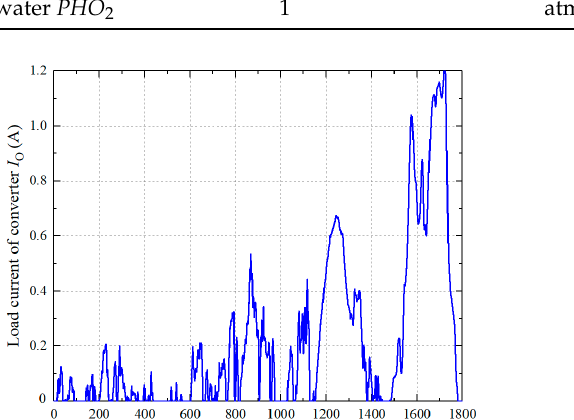
Figure 9. The converter load current under the worldwide harmonised light vehicle test procedure (WLTP).